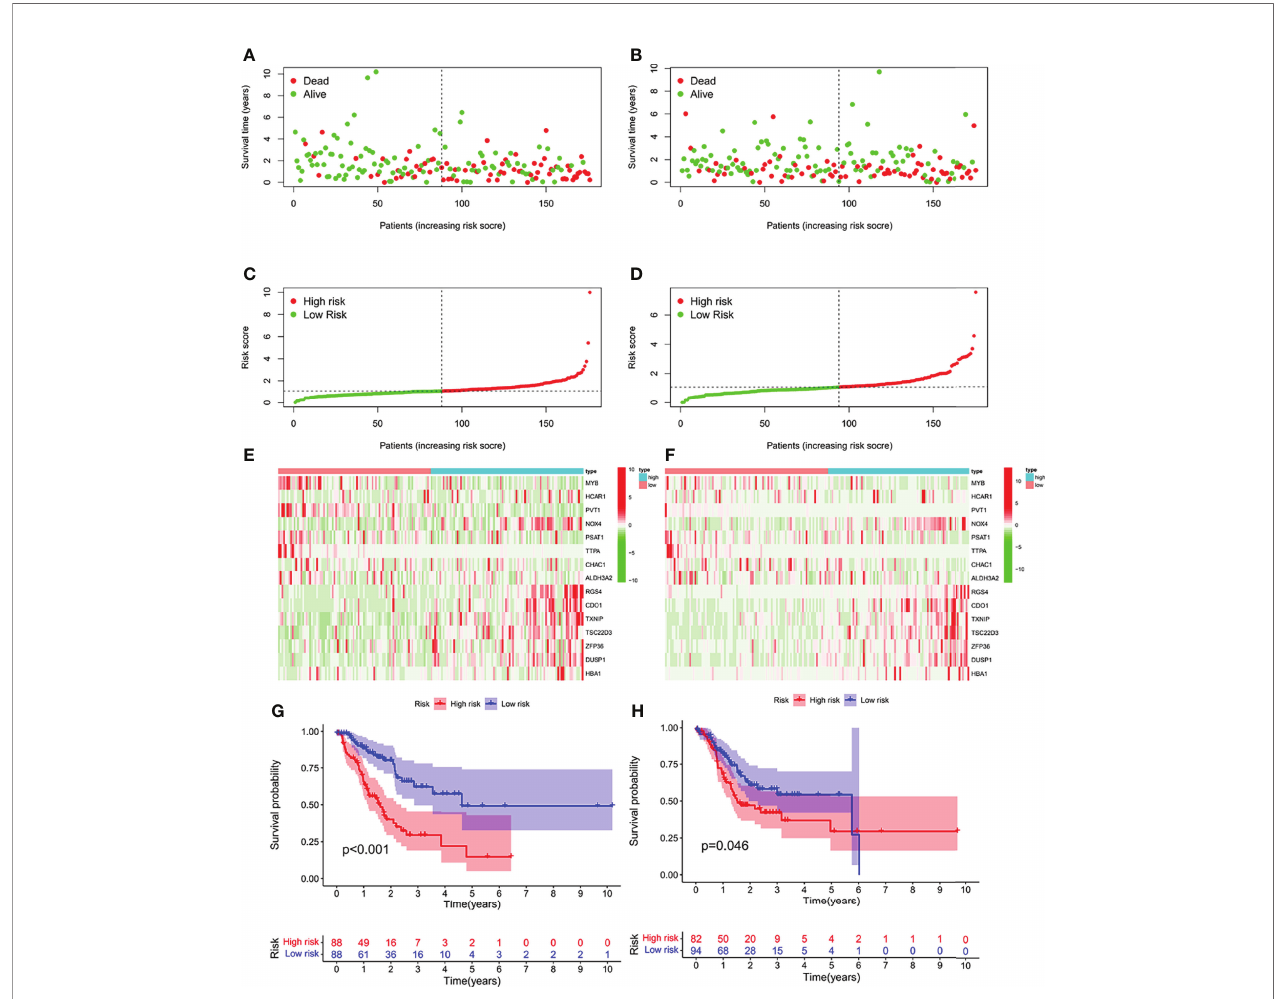
FIGURE 2 | Correlation between the prognostic model and the overall survival (OS) of patients in the TCGA train Cohort (A, C, E, G) , the TCGA test Cohort (B, D, F, H) . The distribution of survival time (A, B) , risk score (C, D) and genes expression levels (E, F) and OS (G, H) . Patients were classi fi ed into low-risk and high-risk groups by using the median score as a cut-off value. The red dots and lines represent the patients in high-risk groups. The green dots and lines represent the patients in low-risk groups. STAD, gastric cancer; KM, Kaplan-Mayer; ROC, receiver operating